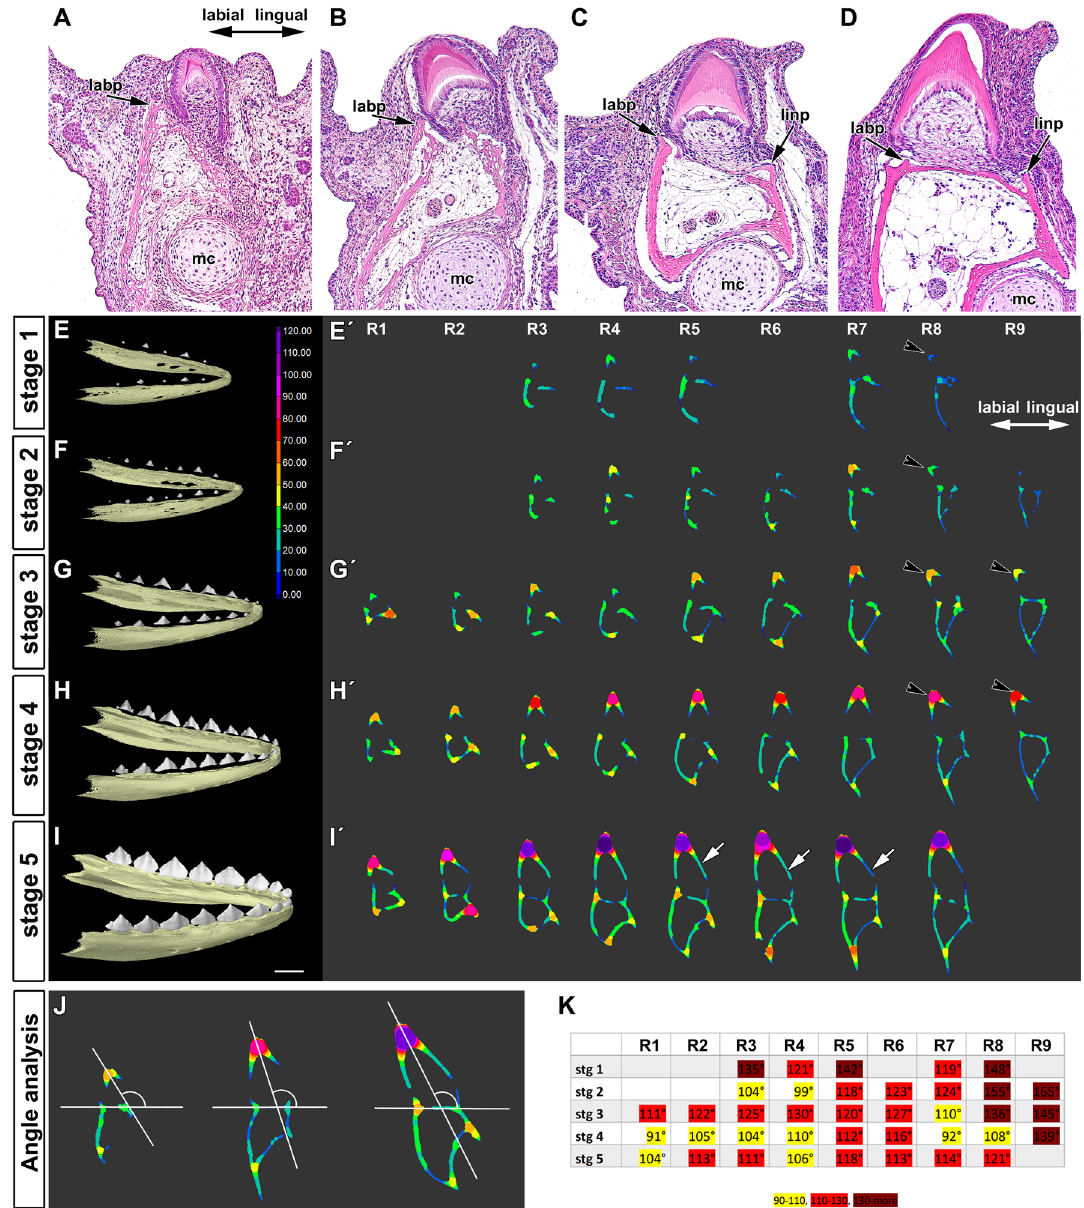
Figure 5. Tooth-bone relationship during prehatching development of chameleon. ( A – D ) Position of tooth and underlying bone during tooth germ development visualized by Haematoxylin–Eosin staining. ( A ) At early mineralization stage, labial bony pedicle ( labp ) was formed in close proximity to the labial part of the cervical loop. ( B ) Later in development, lingual bony pedicle ( linp ) approached extending lingual part of the cervical loop. ( C ) Once the bony pedicles were fully developed, bony lamellae were starting to form. ( D ) Spatial relationship between tooth and bone just before the attachment, when cells of the cervical loop were in direct contact with bone forming cells. mc Meckel cartilage. Scale bar = 50 um. ( E – I ) Lateral view on the 3D images of whole lower jaws and teeth in chameleon embryos ( E ′ – I ′ ). Transversal sections through the central area on each tooth with applied wall thickness analysis. Analysis was performed at five different stages: stage 1 ( E , E ′ ), stage 2 ( F , F ′ ), stage 3 ( G , G ′ ), stage 4 ( H , H ′ ) and stage 5 ( I , I ′ ). Micro-CT imaging revealed that the bone lamellae were thicker on the labial part of the jaw in all analysed developmental stages of chameleon embryo and in the areas of future lamellae branching/fusion. The initiation of bony pedicles mineralization was initiated on the labial side of the dentary bone and later during development progressed to the lingual side. R1 to R9 refer to the individual position of teeth on the right side of the jaw in order from the most rostral teeth (R1) to the tooth in the caudal area (R9). The unit in the colour scale is in µm. White arrows indicate visibly longer hard tissue of the lingual cervical loop. ( J , K ) Analysis of the tooth tilt towards the jaw in the transversal section of the teeth. ( J ) Measurements performed for selected teeth: tooth R7 at stage 2, tooth R8 at stage 4, tooth R5 at stage 5. ( K ) Analysis of the angle between dorsal bony lamellae and tooth axis revealed that the early stages of teeth were located with larger angle to the dorsal bony lamellae ( K ), labelled by black arrows in E ′ – H ′ . Moreover, caudal teeth were inclined in the jaw under different angle in comparison to the rostral teeth. R right tooth on the lower